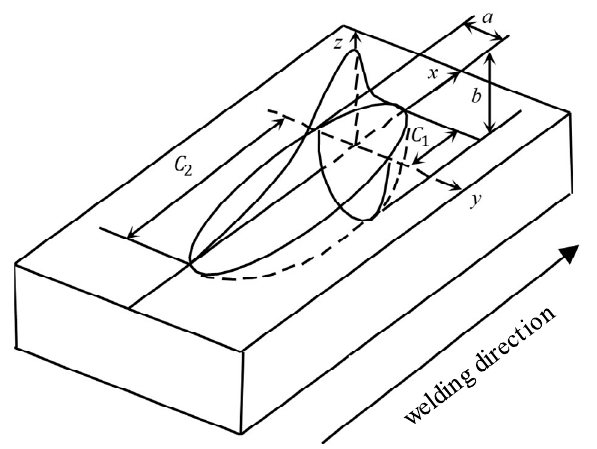
Figure 3. Welding model diagram of an aluminum alloy sheet: ( a ) specimen; ( b ) geometric model; ( c ) finite element model.